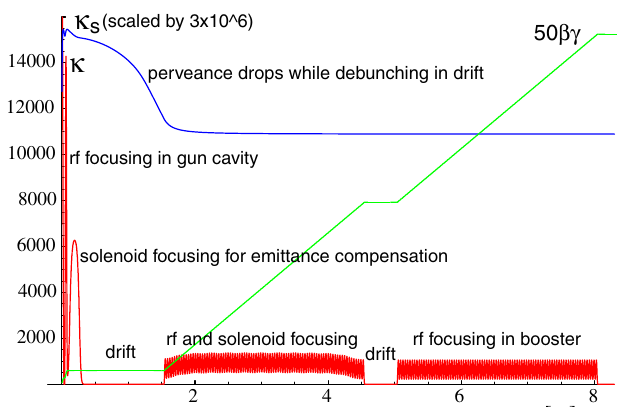
of the central slice in s